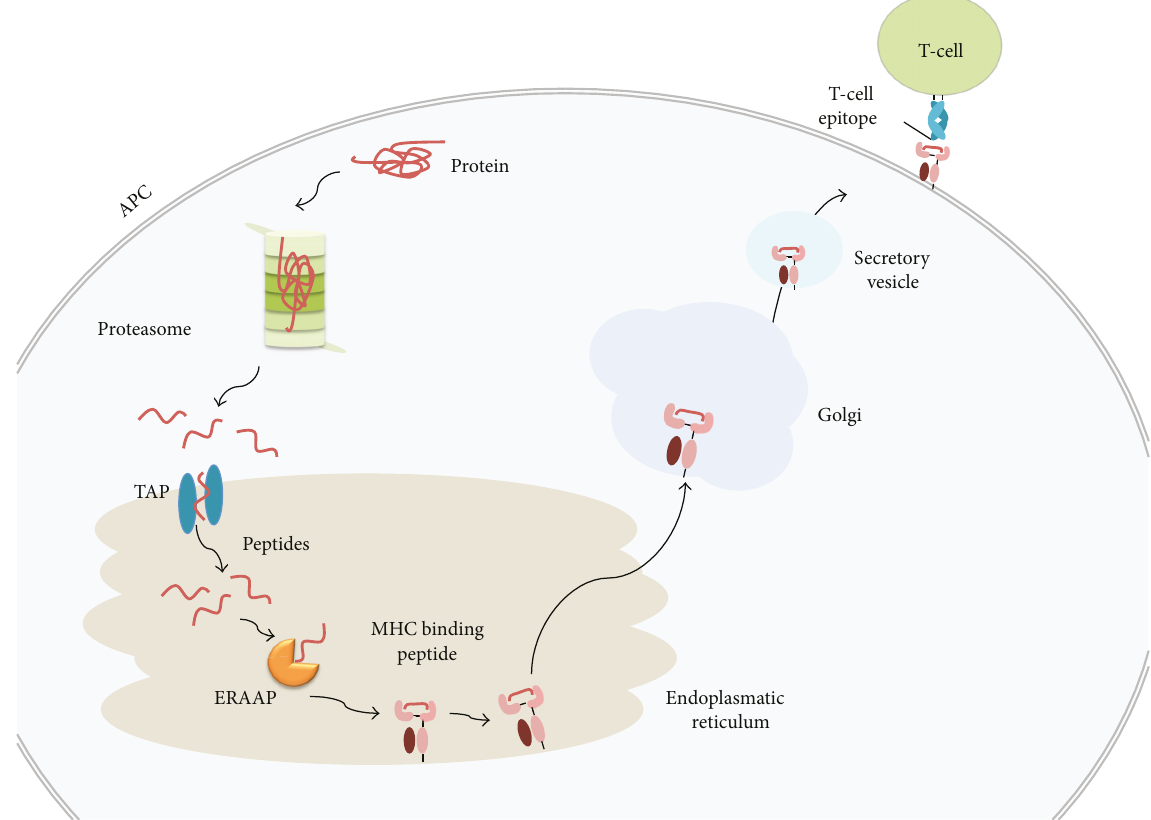
Figure 4: Class I antigen processing. The fi gure depicts the major steps involved in antigen presentation by MHC I molecules. Proteins are degraded by the proteasome and peptide fragments transported to the endoplasmic reticulum (ER) by TAP where they are loaded onto nascent MHC I molecules. TAP transports peptides ranging from 8 to 16 amino acids. Long peptides cannot bind MHC I molecules but often become suitable for binding after N-terminal trimming by ERAAP.